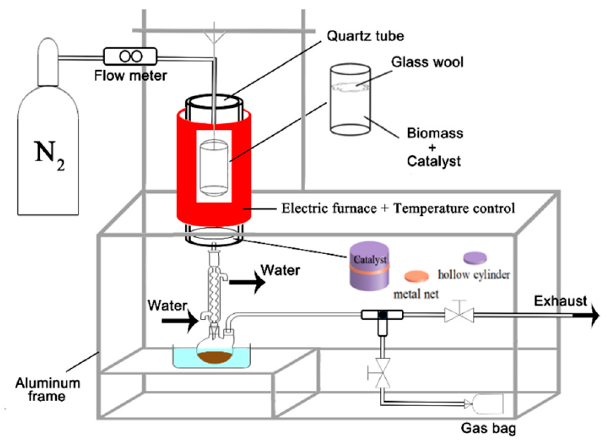
Figure 7. Experimental set-up for the pyrolysis experiment.